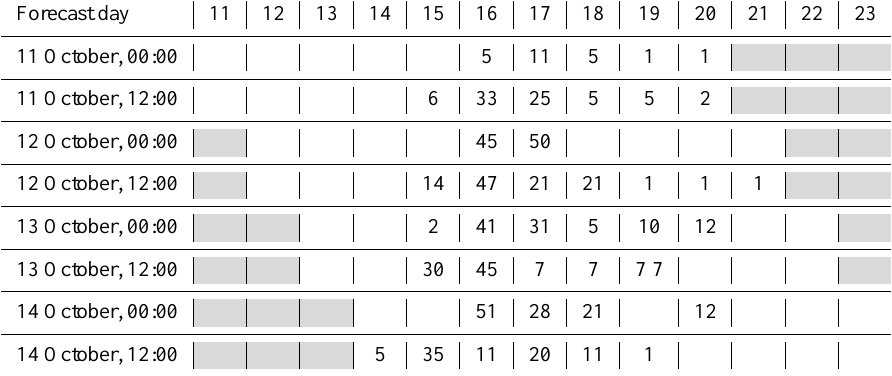
Table 2. Number of Ensemble members (out of 51) exceeding a high alert level. The rows indicate the date and time that the forecast was issued and the columns indicate the date for which the forecast was issued. Forecast